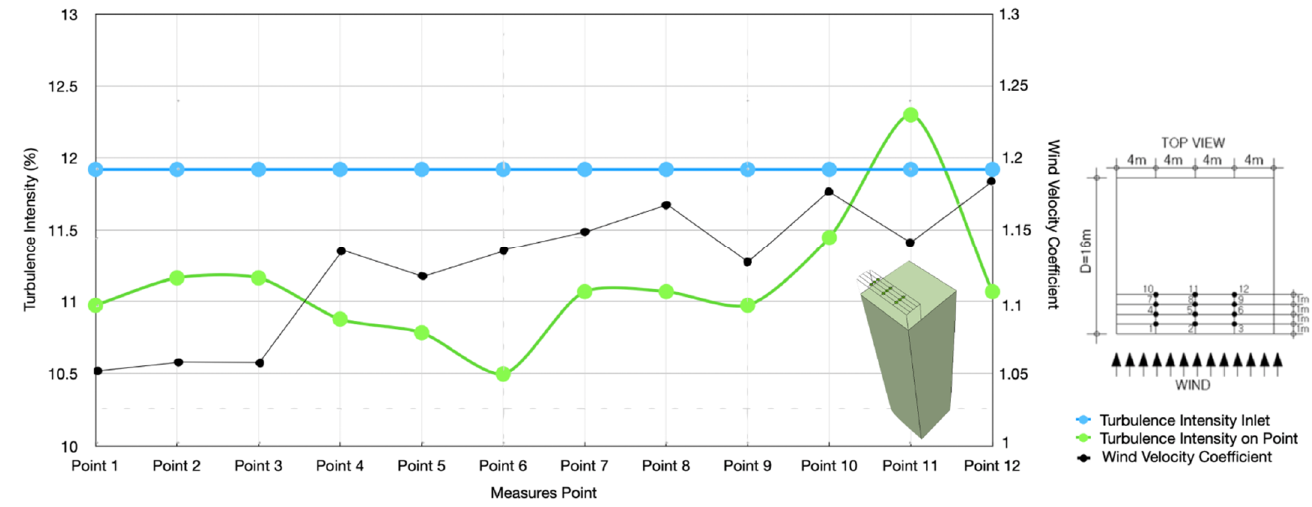
Figure 8. A wind tunnel test on Building A resulted in a measurement of the velocity coefficient (VC) and turbulent intensity (TI). Wind turbines were recommended to be installed in points 4 through 10, with an overall increased wind velocity of 10% over the wind velocity approach. With the exception of point 11, TI percentages were lower than the TI inlet.